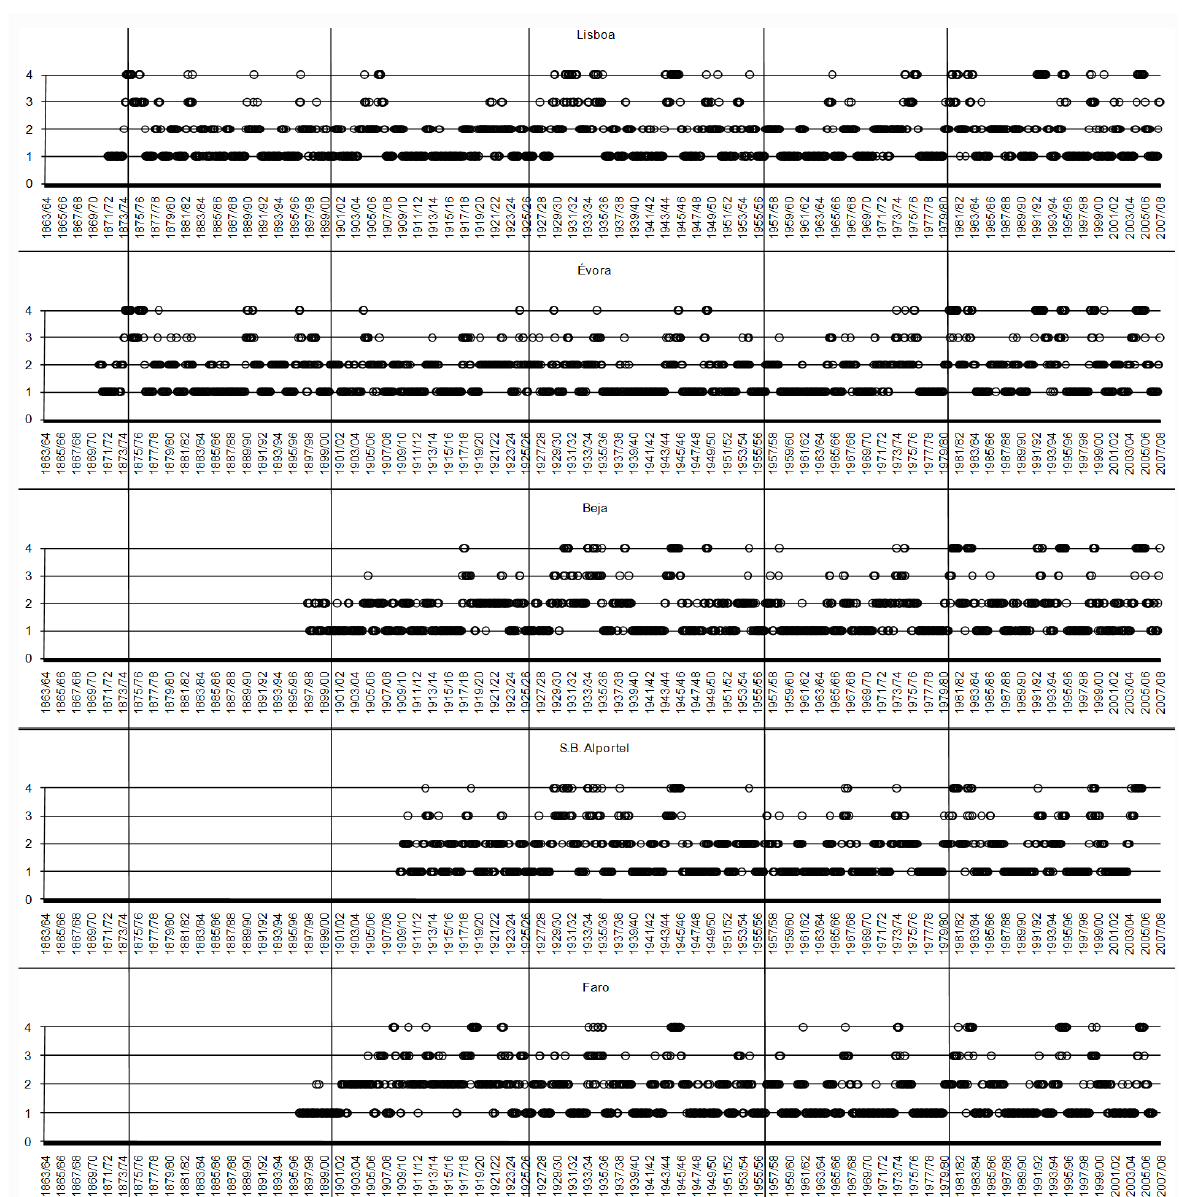
Fig. 3. Drought classes (Table 2) through time by location (cont.) (sub-periods are indicated with vertical lines).